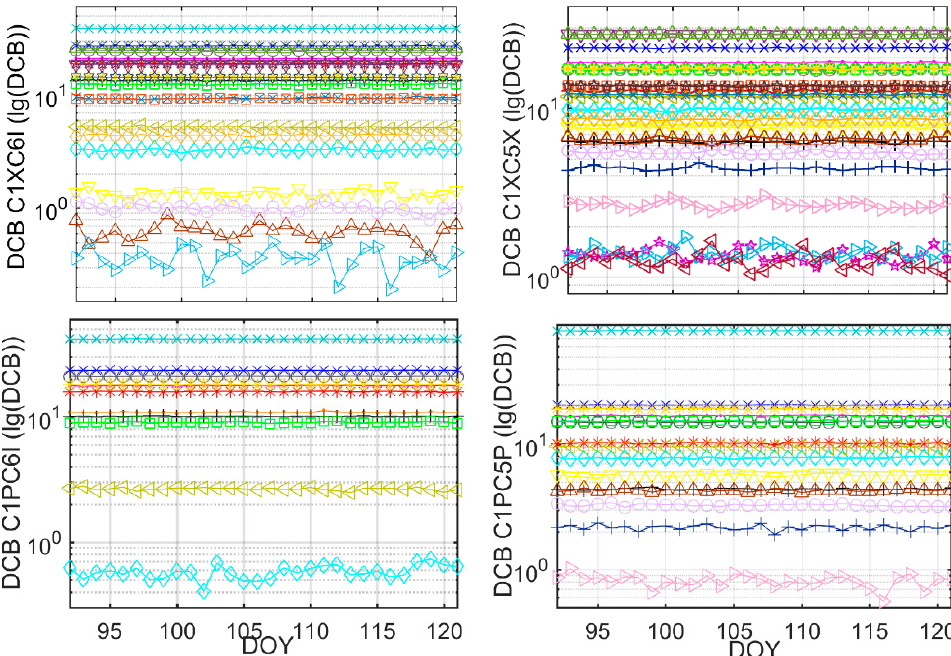
Figure 2. Time series of daily DCBs (lg ( DCBs ) ).